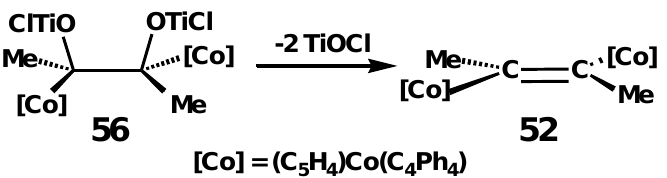
Scheme 16. McMurry coupling of (C 4 Ph 4 )Co[C 5 H 4 C(=O)Me] to form the trans -alkene, 52 .